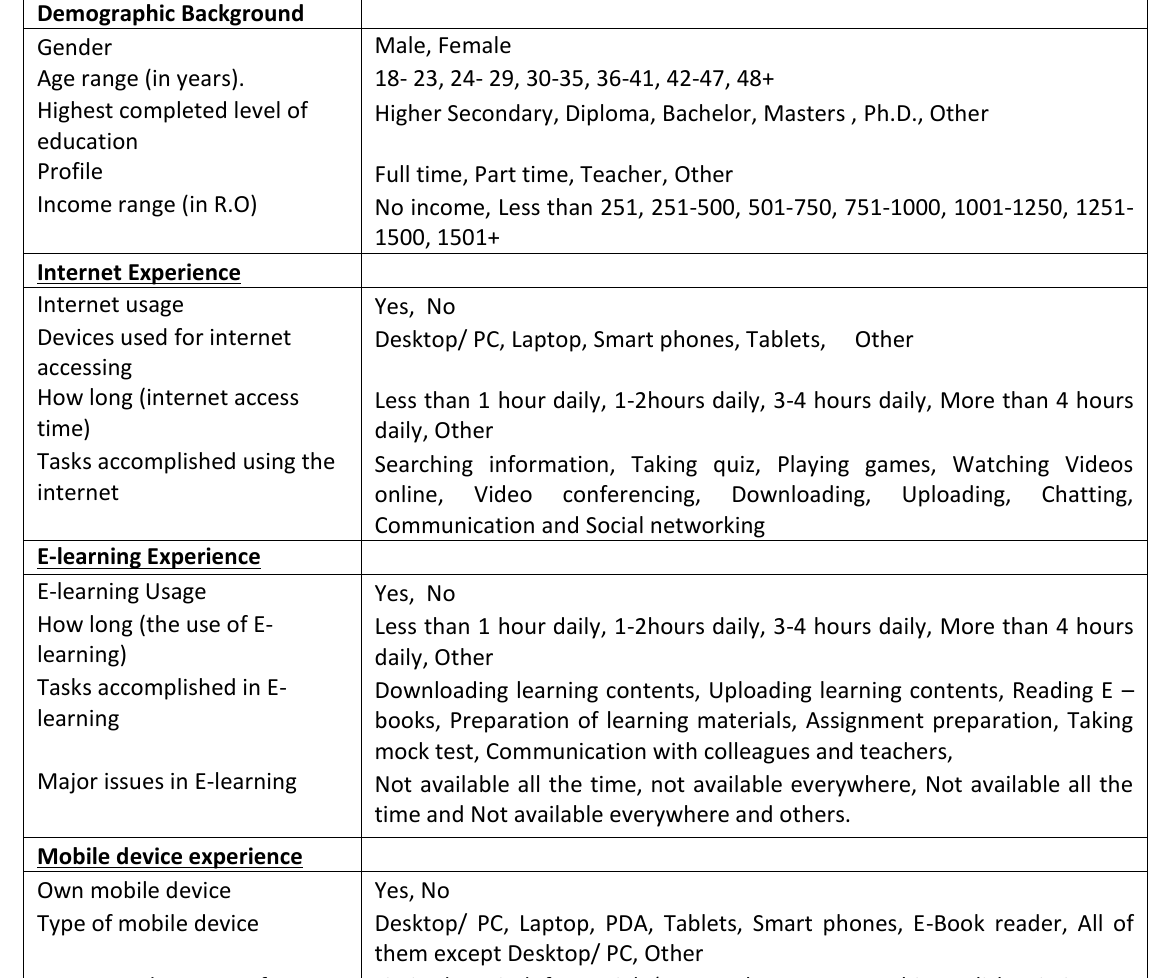
An Empirical Study Survey Items Demographic